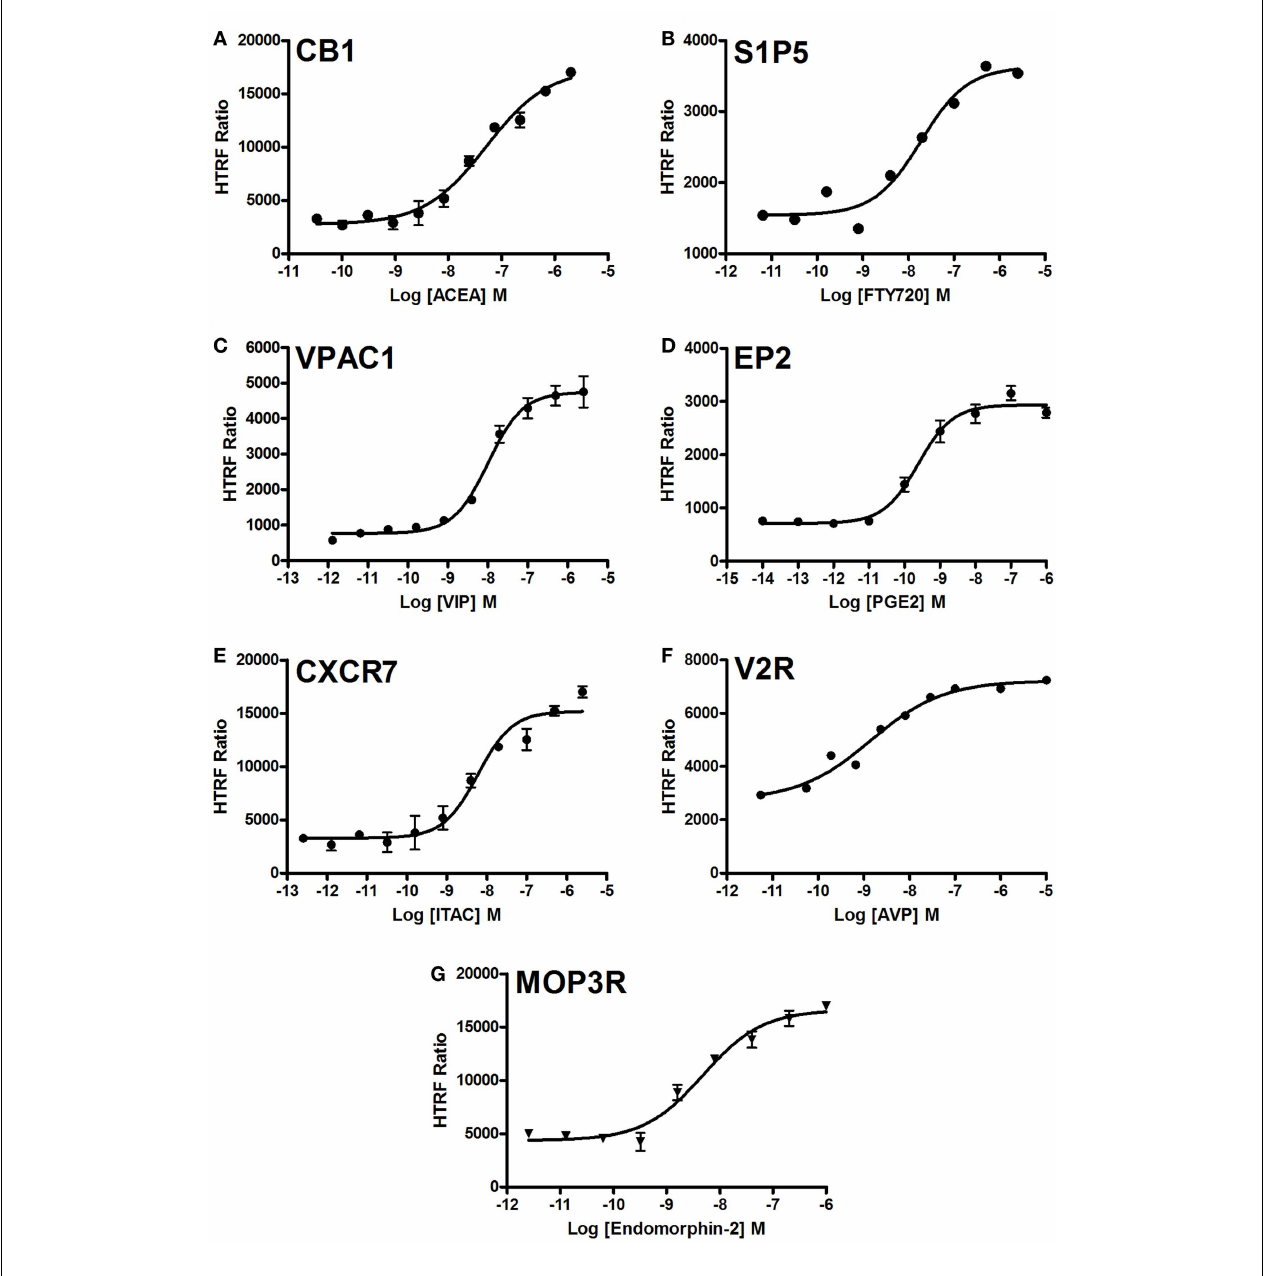
Cells were stimulated for 10min with increasing concentrations of each GPCR-selective agonist as indicated before HTRF measurements were performed using the one-plate protocol.The figures are representative of three independent experiments performed in single points or duplicate.